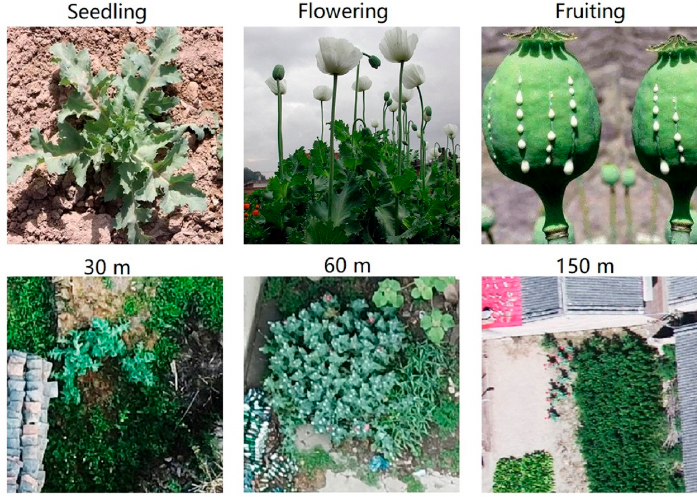
Figure 1. The characteristics of poppies at different growing periods and flying heights.